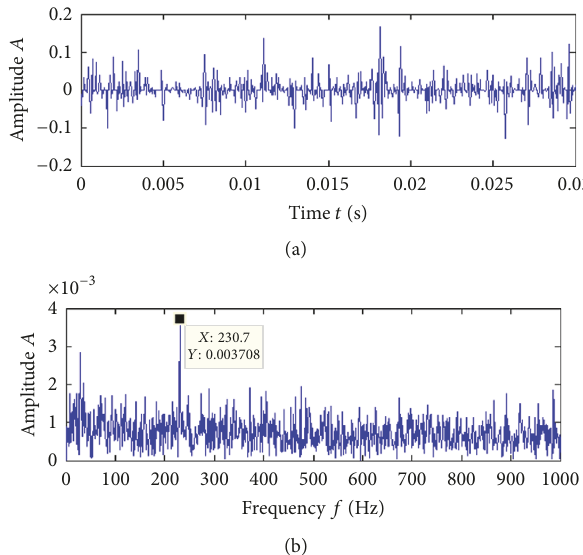
Figure 10: Extraction result of early outer race fault: (a) time waveform and (b) envelope spectrum.